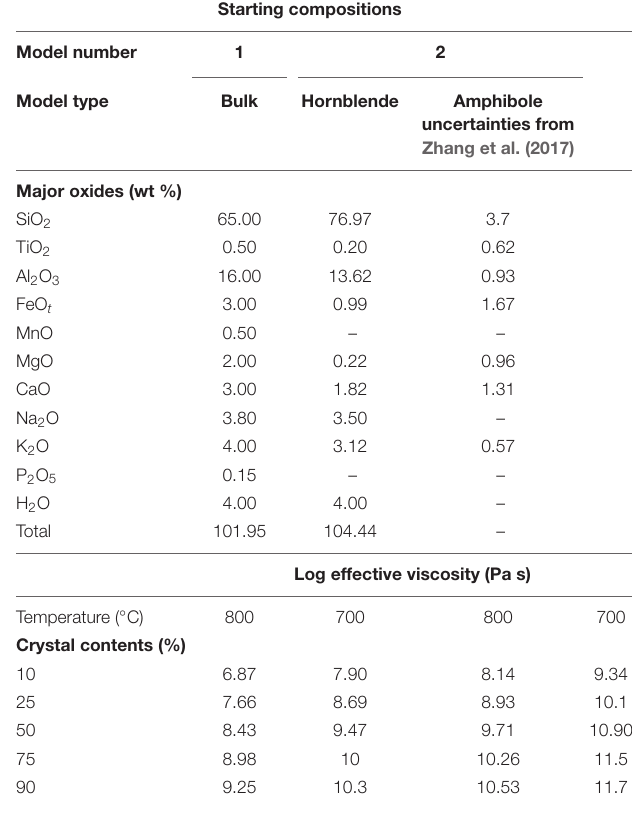
TABLE 3 | Viscosity